Question: Draft a figure caption describing what is shown.
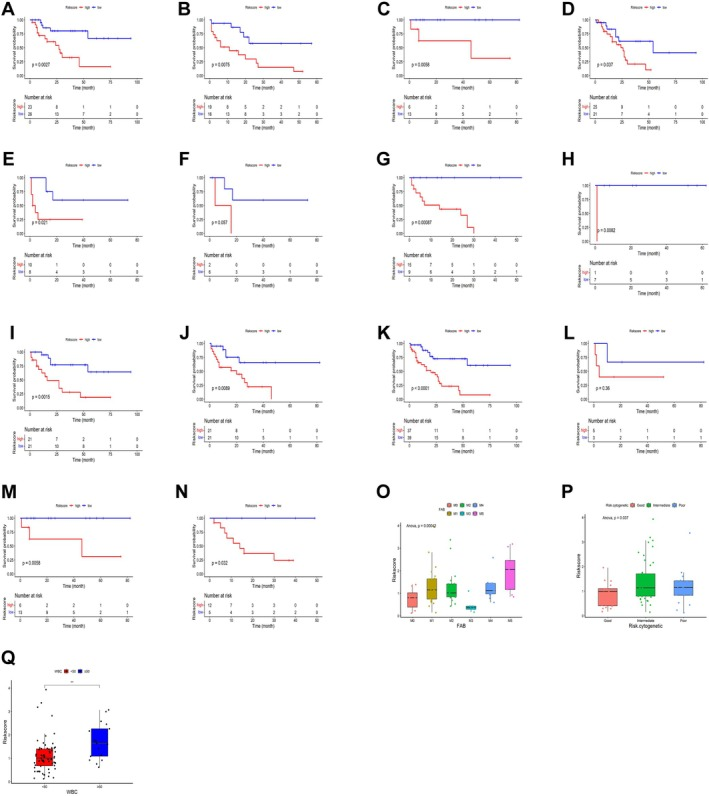
Answer: Association of clinical characteristics with overall survival and their distribution in the train set. (A–N) Kaplan–Meier analyses of OS according to clinical characteristics in the train set. Patients were stratified by age (< 60 [A] vs. ≥ 60 years [B]); risk cytogenetic (good [C], intermediate [D], poor [E]); FAB subtype (M0 [F], M1 [G], M3 [H]); gender (male [I], female [J]); prior malignancy (no [K], yes [L]); and WBC count (< 50 [M] vs. ≥ 50 [N]). Survival differences were assessed using the log‐rank test. (O–Q) Distribution of clinical variables and risk score across patient groups. (O) Boxplot of risk score across FAB subtypes. (P) Risk score distribution among risk cytogenetic categories. (Q) Comparison of WBC levels between groups. Statistical significance was assessed using nonparametric tests, with p ‐values indicated. These analyses further illustrate the relationships between clinical features, risk stratification, and patient prognosis in AML. FAB, French–American–British classification; OS, overall survival; WBC, white blood cell.